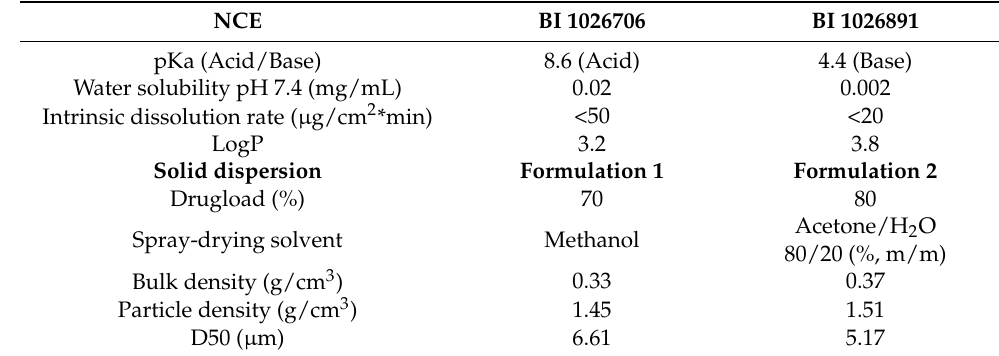
Table 1. Physicochemical parameters of crystalline NCEs and corresponding spray-dried formula- tions applied in preclinical testing. NCE BI 1026706 BI 1026891 pKa (Acid/Base) 8.6 (Acid) 4.4